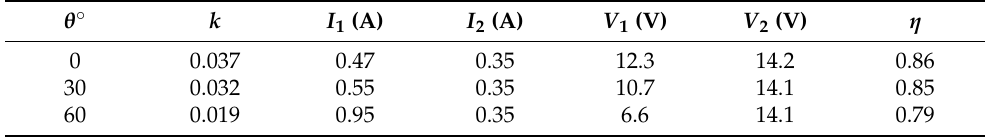
Table 1. Electrical quantities vs. device inclination ( θ